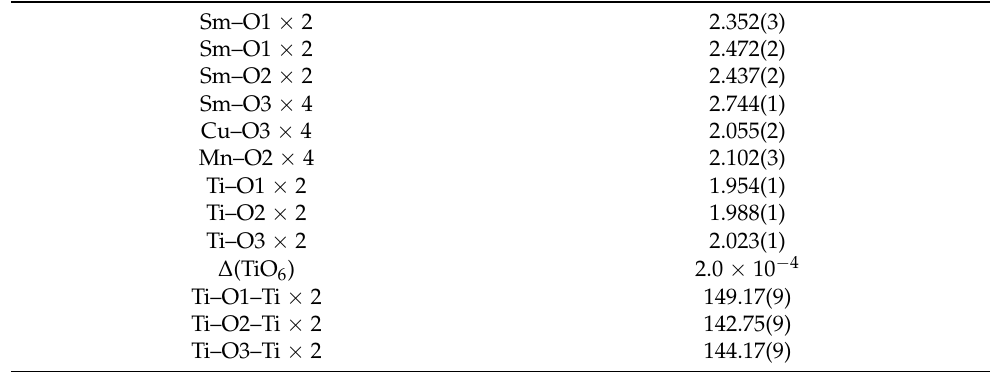
Table 2. Bond lengths (in Å), bond angles (in deg), and distortion parameters of TiO 6 ( ∆ ) in Sm 2 CuMn(MnTi 3 )O 12 at room